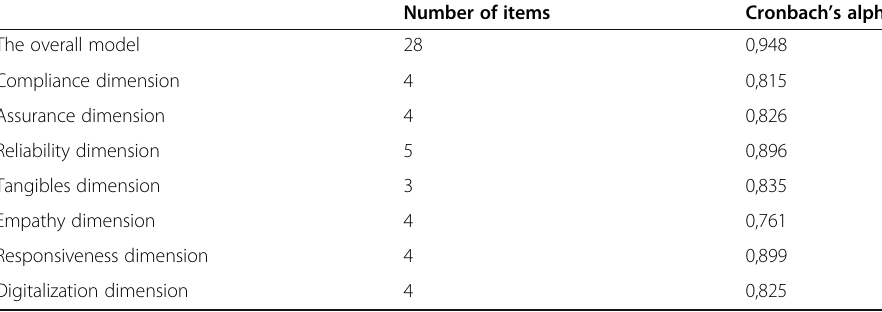
Table 1 Reliability